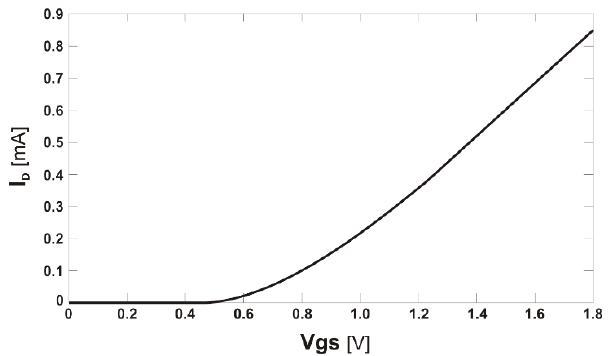
Figure 1. I D versus V gs .